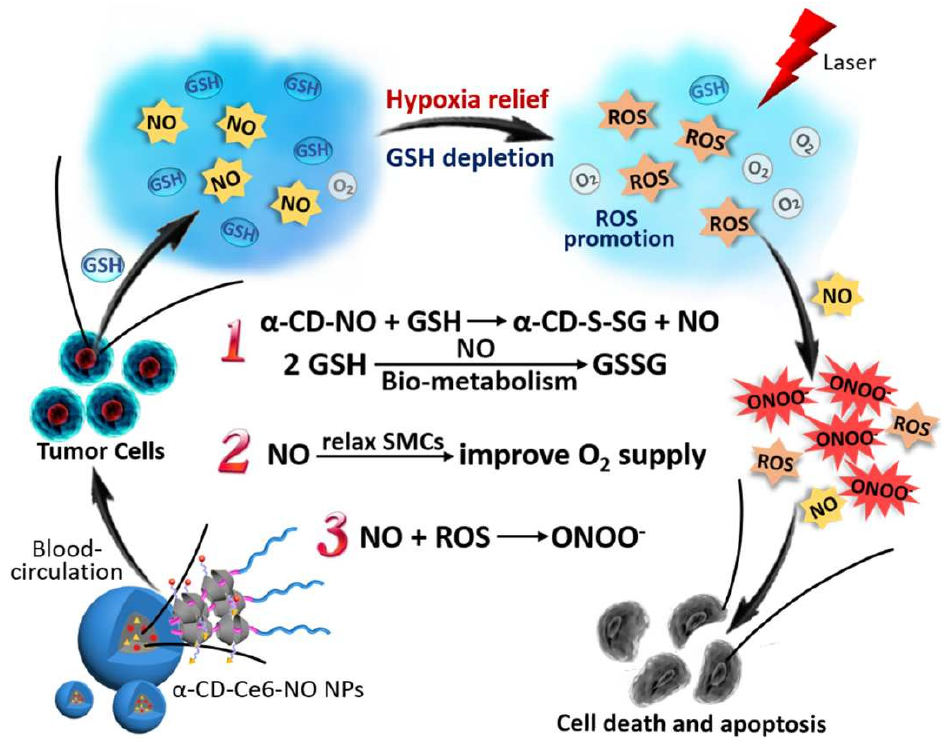
Figure 7. Multiple synergistic effects between NO and PDT generated from the supramolecular nanoparticles α -CD-Ce6-NO nanoparticles to improve therapeutic efficacy. (Adapted with permission from Ref. [68]. Copyright 2018, Elsevier).